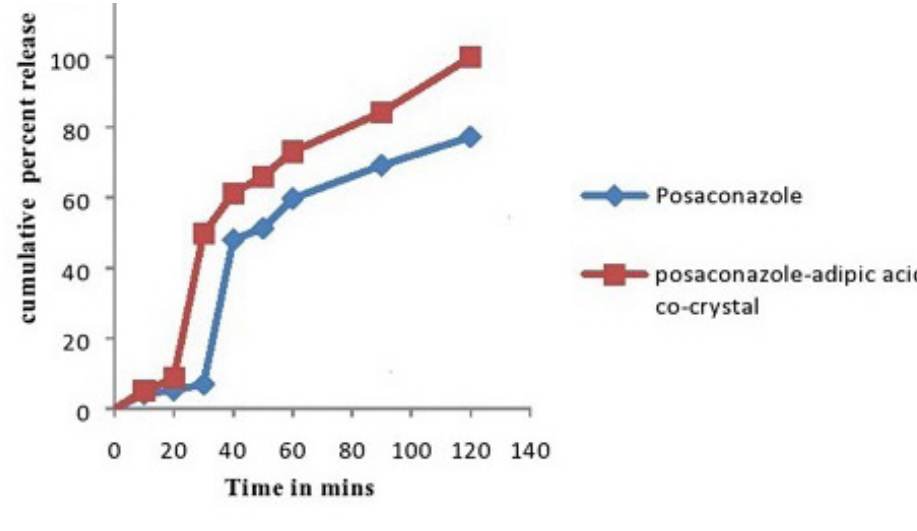
FIGURE 5 - Dissolution-time profile of posaconazole and posaconazole-adipic acid